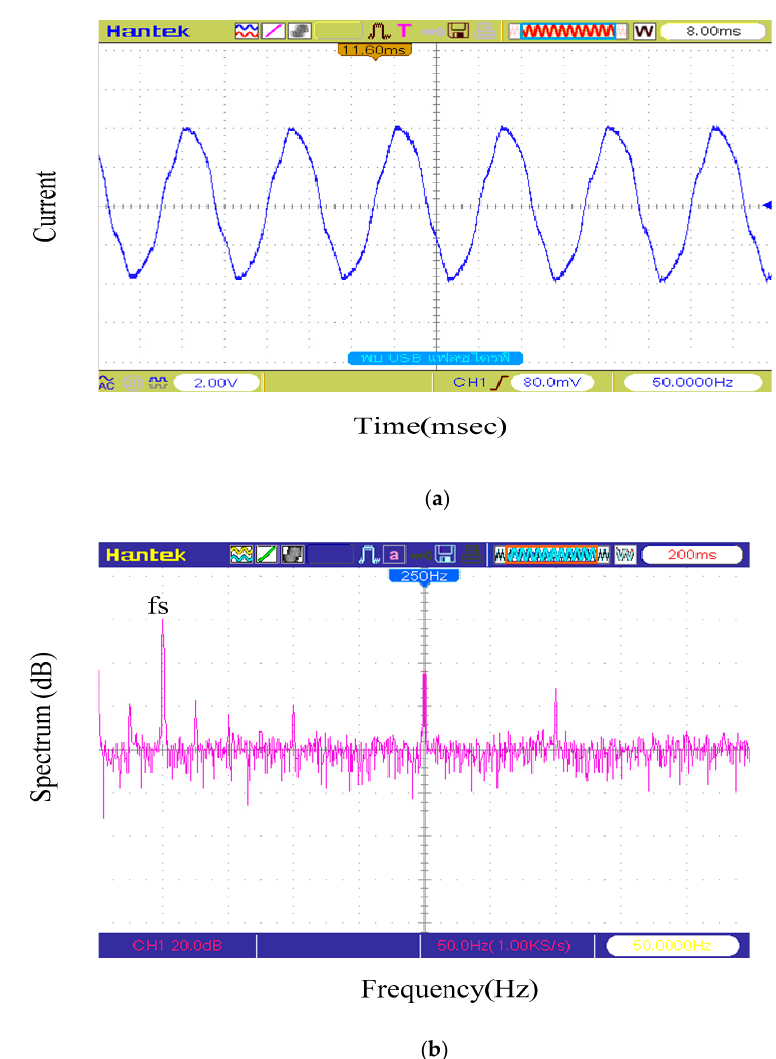
Figure 7. The current signal in the time domain and frequency domain motor without load condition. ( a ) shows the results of measuring motor current signals in the time domain, whose signal characteristics are non-sinusoidal due to magnetism and hysteresis. ( b ) shows the signal measurement in the frequency domain using the FFT function; when the motor operates, it produces MMF, resulting in the rotor frequency fr = sfs , causing a difference in frequency, and the sideband of the fundamental frequency is obtained for the motor in its normal state. The slip frequency has an energy (dB) value that is lower than the main frequency value fs. The peak (Peak) of the spectrum signal with an odd order (third (150 Hz), fifth (250 Hz), seventh (350 Hz), and ninth (450 Hz)) is obtained, which has a lower energy value than the main frequency. From Figure 8, by using wavelet decomposition (WD) of the frequency signal, the stator current is divided into four levels including d1, d2, d3, and d4, and one power co- efficient out, a4. It can be seen that the harmonic current can appear on both stator and rotor currents. According to Equations (3)–(5), the energy coefficient of stator current can be computed as in Table 2.